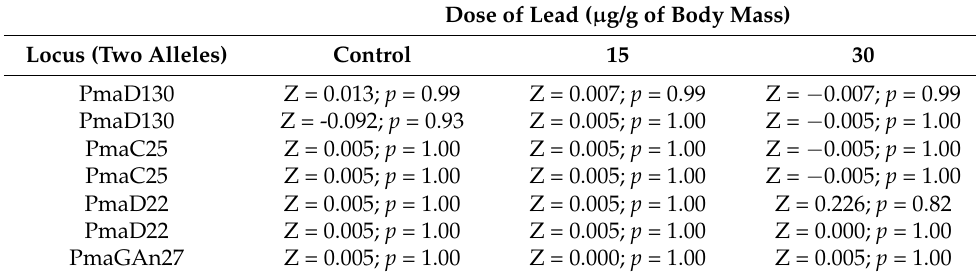
Table 2. Results of the Mann–Whitney U test for the comparison of the mean allele sizes of SSRs genotyped twice for the studied individuals, with respect to the dose at which nestlings were supplemented with